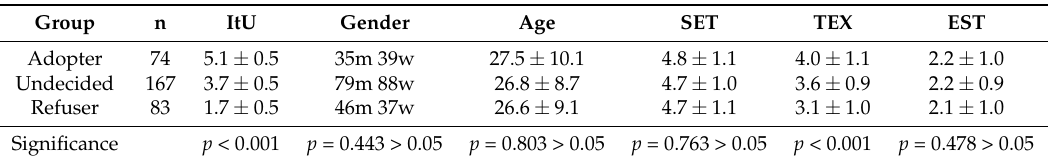
Table 2. Identified user segments for the smart armchair and link to explanatory user variables (ItU: Intention to Use; SET: Self-efficacy in interacting with technology; TEX: Attitude towards textiles; EST: Experience Smart